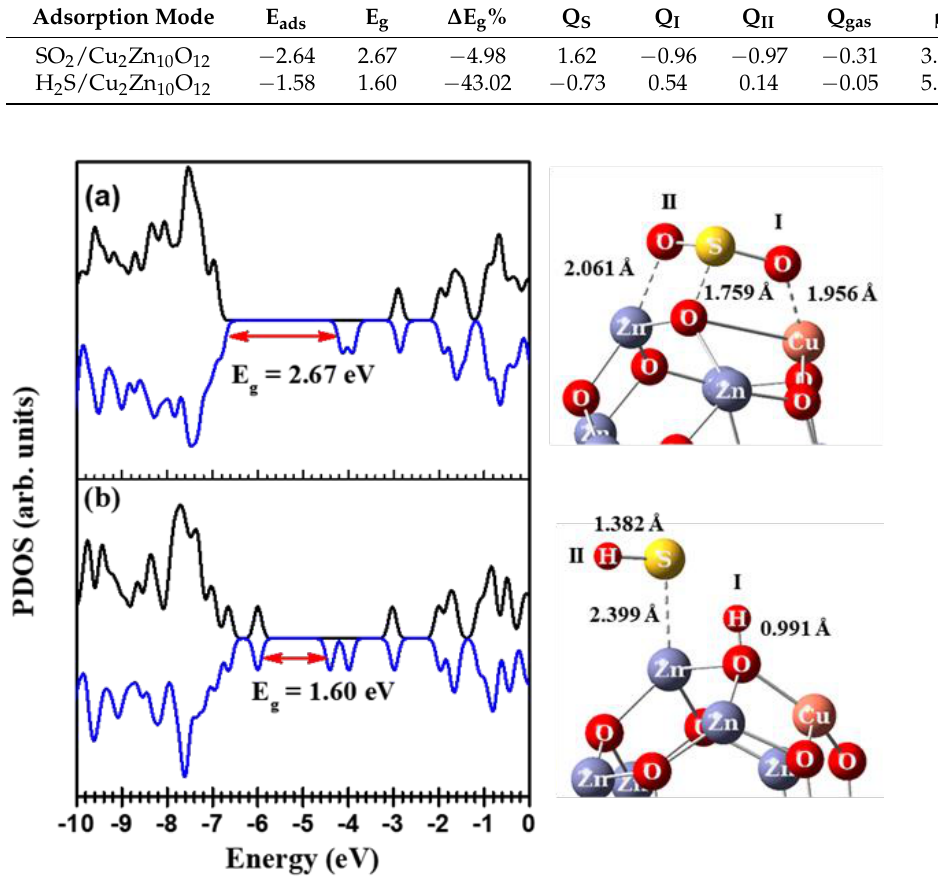
Figure 7. The DOS and the optimized structures for ( a ) SO 2 /Cu 2 Zn 10 O 12 (mode III) and ( b ) H 2 S/Cu 2 Zn 10 O 12 (mode V).